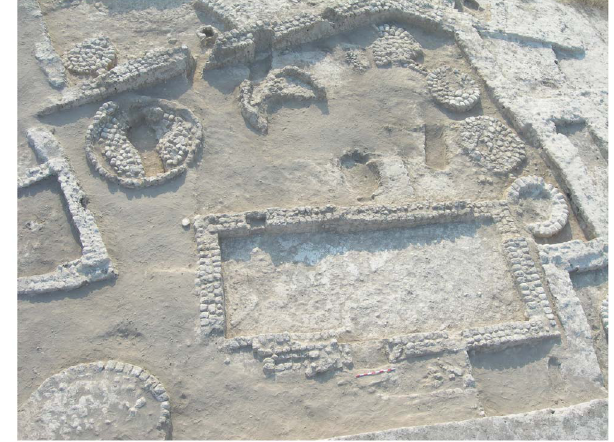
Figure 2. General view of Courtyard Building 1. The silo in which the burial was found is located in the upper left